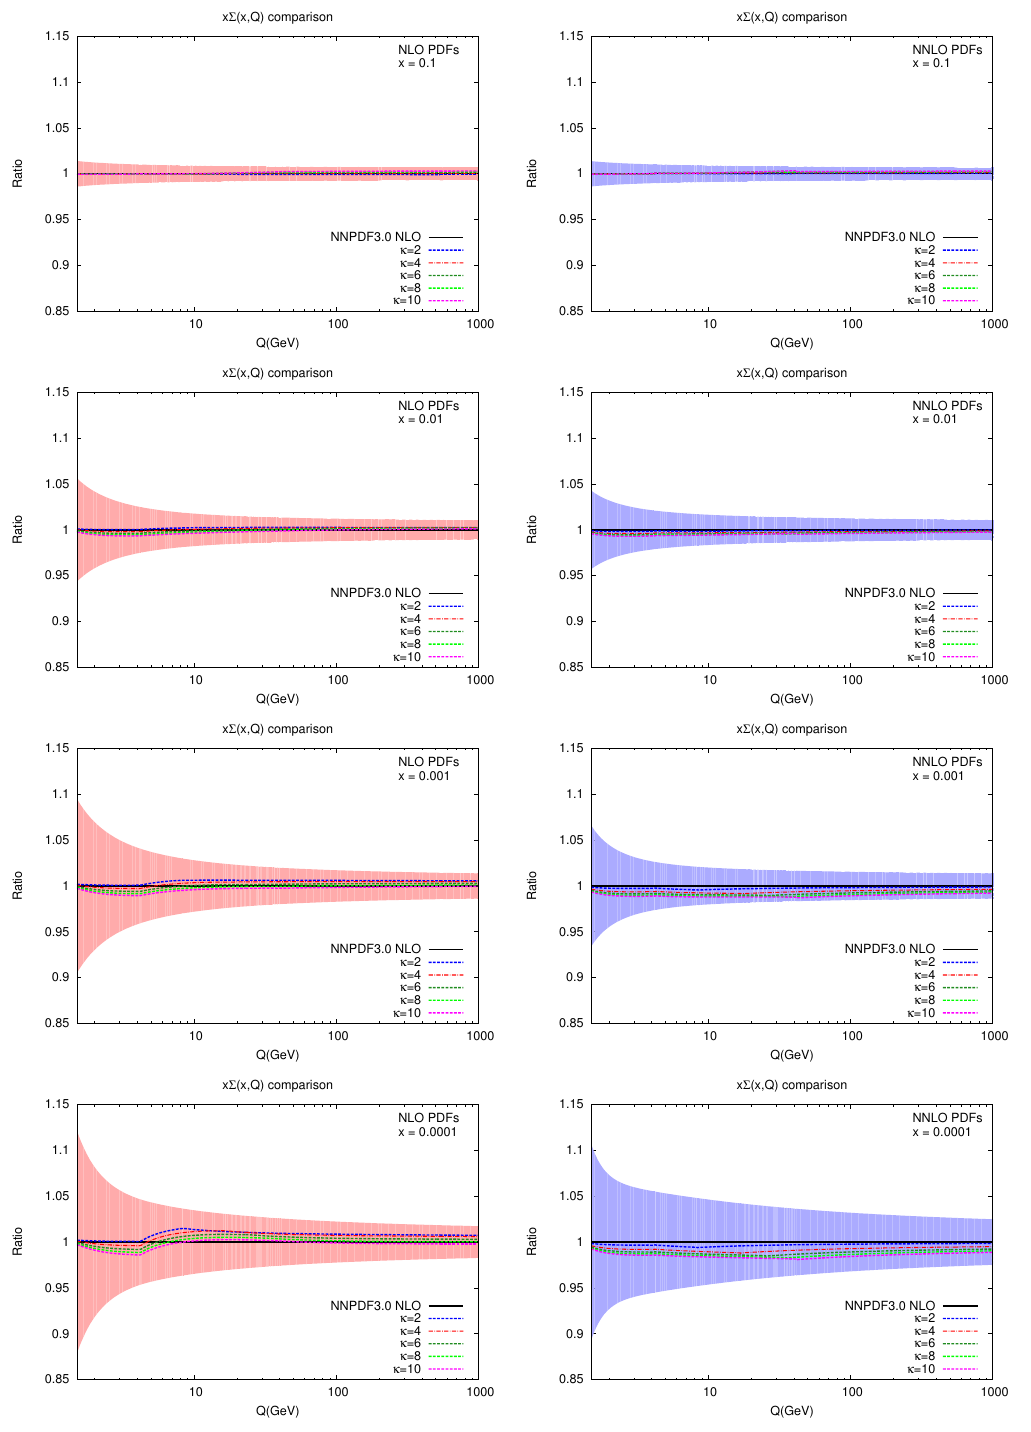
Figure 16 . As in (cid:12)gure 13 but for (cid:6) = u + (cid:22) u + d + (cid:22) d + s + (cid:22) s + c + (cid:22) c .